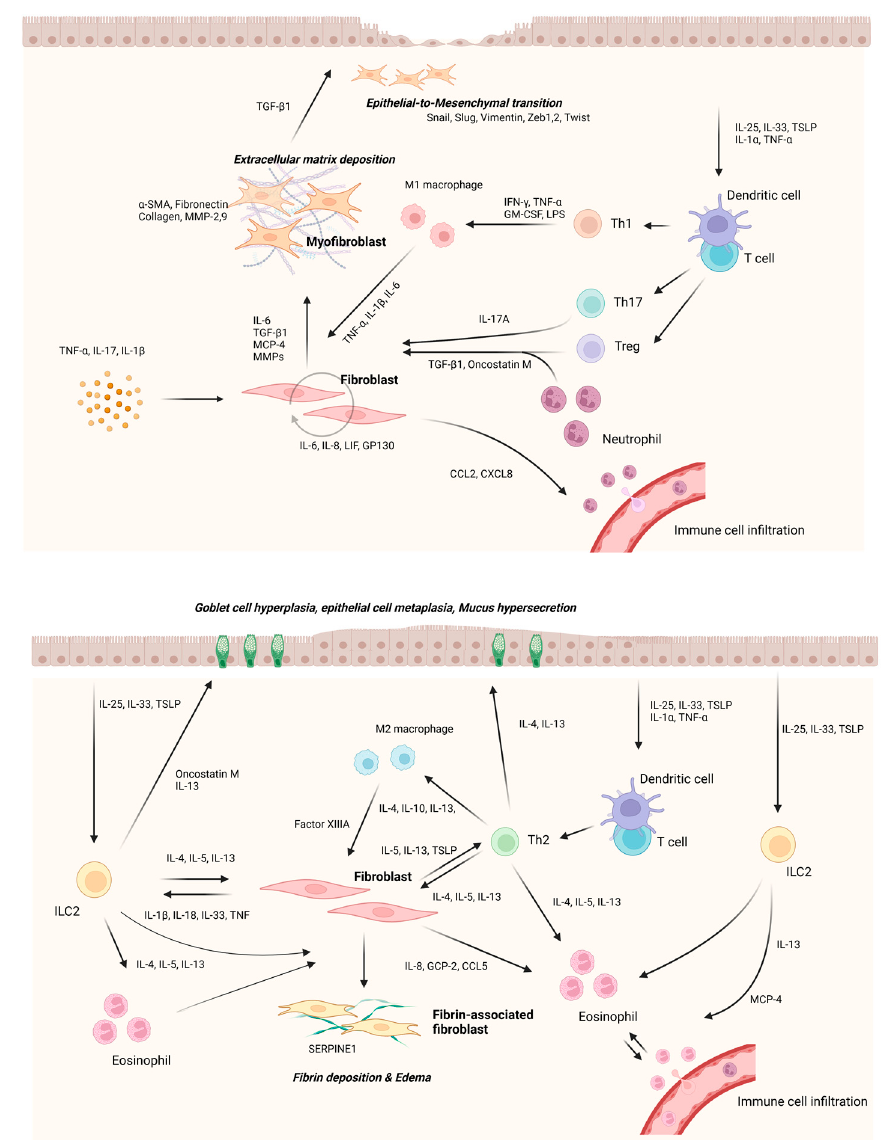
Figure 4. Interaction between fibroblasts and immune or other structural cells. Fibroblasts induce overall tissue remodeling of the nasal mucosa through cross-talk with neighboring cells. Interaction between nasal fibroblast and surrounding cells in Th1, Th17, or non-eosinophilic based immune response (upper panel). Interaction between nasal fibroblast and surrounding cells in Th2 or eosinophilic-based immune response (lower